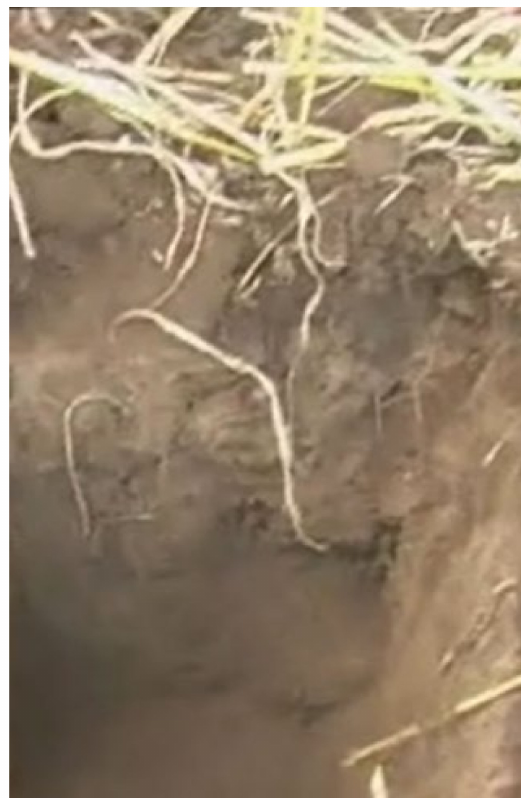
Figure 5. Solonetz soil profile wall in the layer 0–35 cm after moldboard plowing. Eluvial (0–18 cm) and illuvial (18–35 cm) soil horizons.